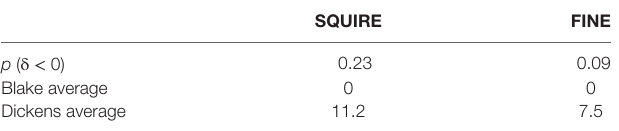
Table 3 | Bayesian probability estimates (based on 2,000 samples) for two distinctive words (SQUIRE, FINE) with usage rates (1/1,000) in Blake’s and Dickens’ poems of the